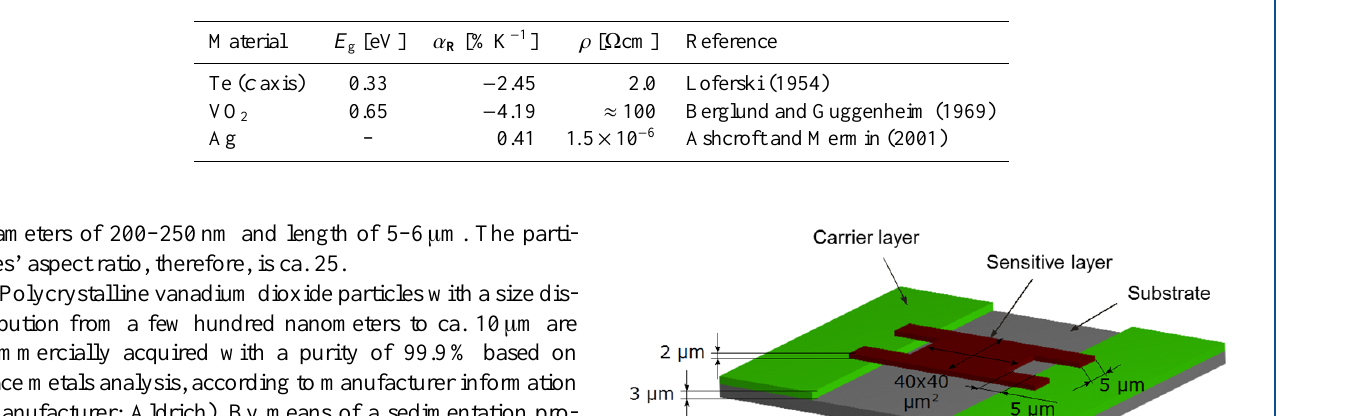
Table 1. Electrical properties of the examined materials at room temperature (300K): band gap E g ; temperature coe ffi cient α R of resistance and resistivity ρ .